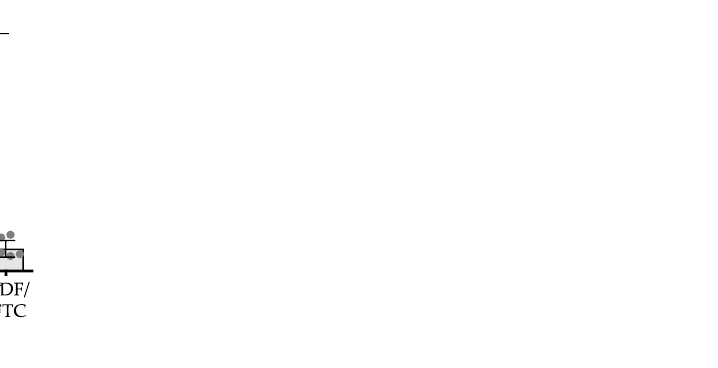
Figure 4. Placental MDA levels are elevated in pregnant mice treated with AZT/3TC. Placental concentrations of MDA of mice exposed to AZT/3TC (red dots), ABC/3TC (blue dots), TDF/FTC (grey dots), or water (control; black dots). Data are scatter dot plots with mean and 95% confidence interval (n = eight placentas from four litters for control; n = four placentas from six litters for AZT/3TC; n = seven placentas from four litters for ABC/3TC; n = seven placentas from four litters for TDF/FTC). Statistical comparisons by mixed-effects modelling to control for litter effects (using treatment as a fixed effect and litter as a random effect). *** = p < 0.001. The p -value below the panel is for the model. AZT, zidovudine; 3TC, lamivudine; ABC, abacavir; FTC, emtricitabine; TDF, tenofovir; MDA, malondialdehyde.